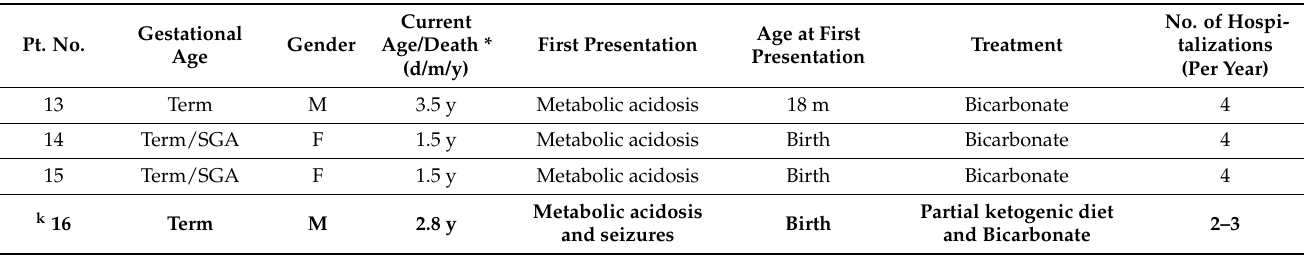
Table 3. Further clinical characteristics in patients with dihydrolipoamide dehydrogenase deficiency: hypoglycemic events and developmental milestones. Pt.